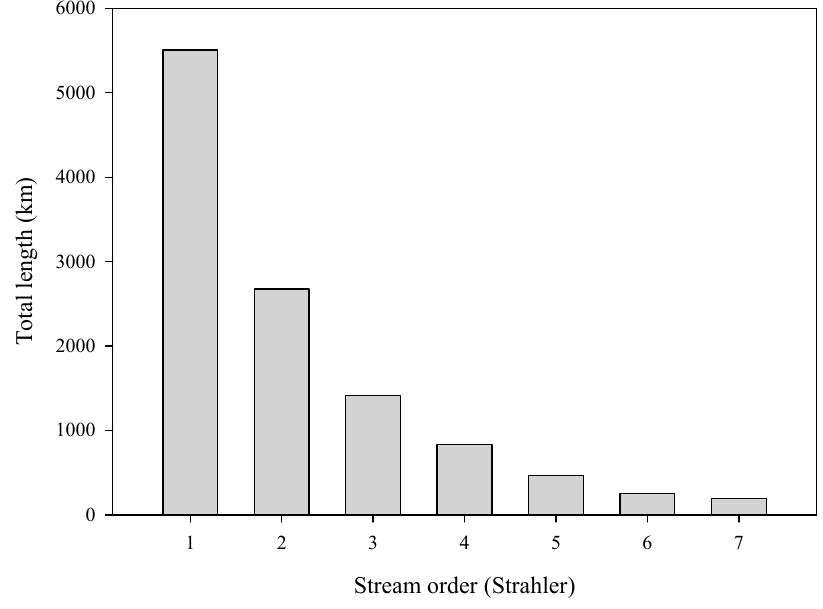
Figure 4. Stream length of different stream order of the Grand River stream network.